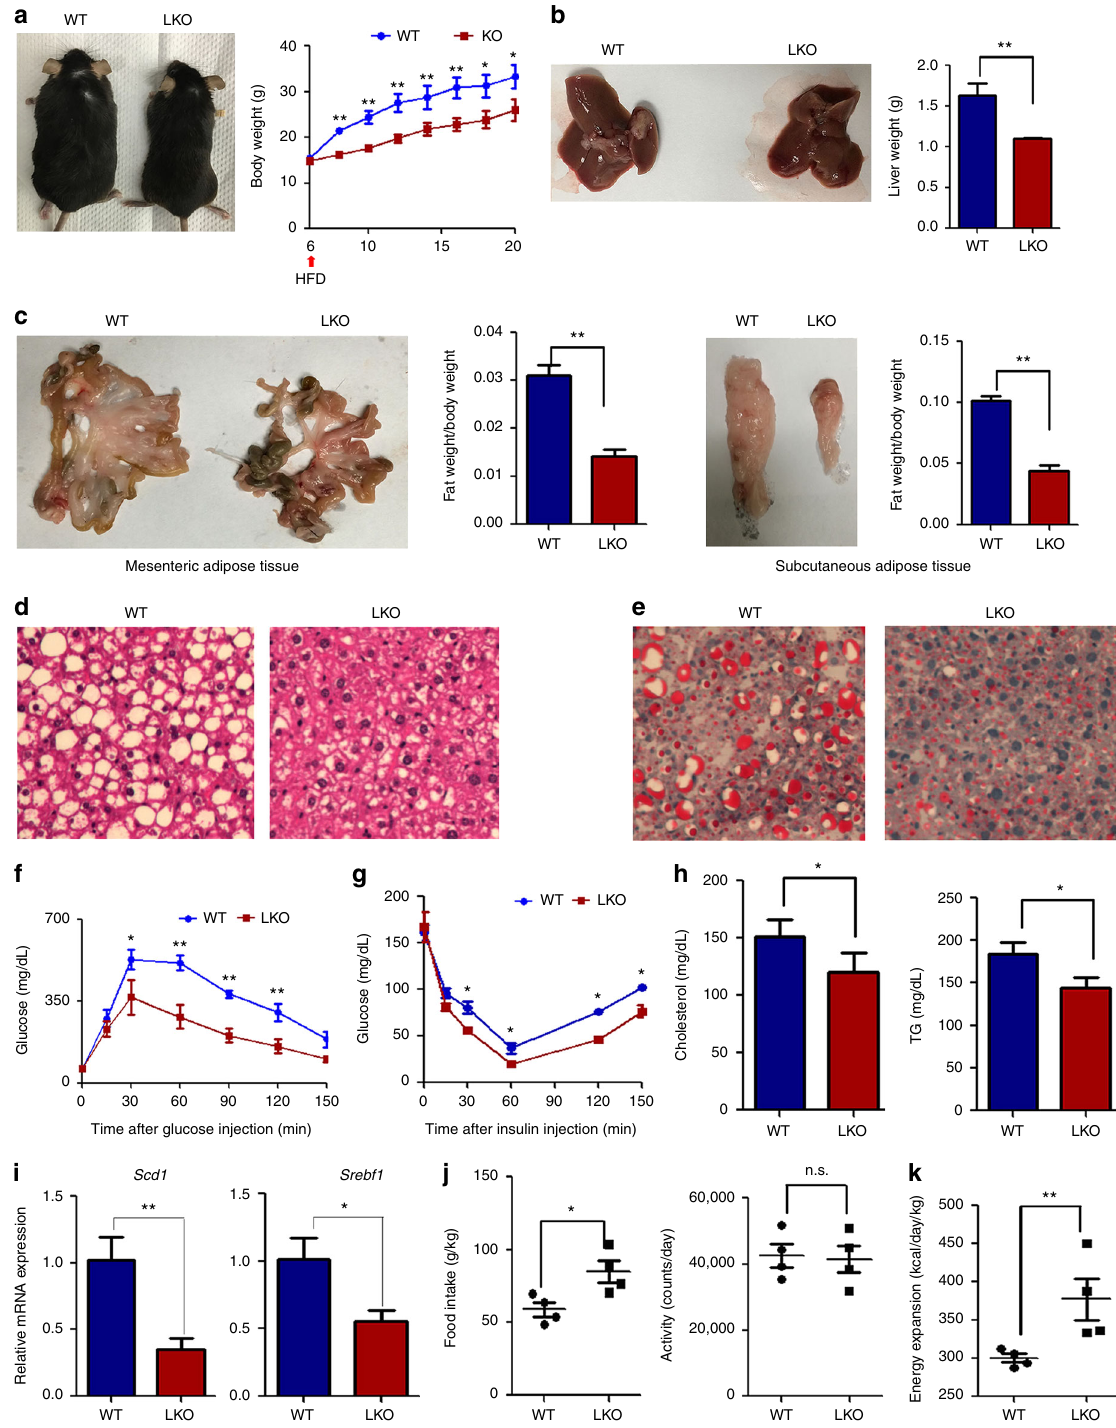
Fig. 2 HRD1 inhibition protects mice from HFD-induced obesity and fatty liver disease. a Body weights of WT and HRD1 Alb mice fed a HFD were measured every 2 weeks. Liver ( b ) and fat ( c ) weights from WT and HRD1 Alb mice fed a HFD for 14 weeks ( n = 6 for each group). H&E ( d ) and Oil Red O ( e ) staining of the liver from b ( n = 6 for each group). Glucose tolerance assay ( f ) and insulin tolerance assay ( g ) were performed on mice after 14 weeks of a HFD ( n = 6 for each group). h Serum TG and cholesterol levels from WT and HRD1 Alb mice after 14 weeks of a HFD under the refed condition ( n = 6 for each group). i Hepatic gene expression of Srebp1 and Scd1 in WT and HRD1 Alb mice after 14 weeks of a HFD under the refed condition ( n = 6 for each group). j Food intake, body weight ratios, and activities of WT and HRD1 Alb mice after 14 weeks of a HFD ( n = 4 for each group). k Energy expenditure of WT and HRD1 Alb mice after 14 weeks of a HFD ( n = 4 for each group). The data are representative of three independent experiments (mea n ± s.d.). * P < 0.05. ** P < 0.01 by unpaired Student ’ s t